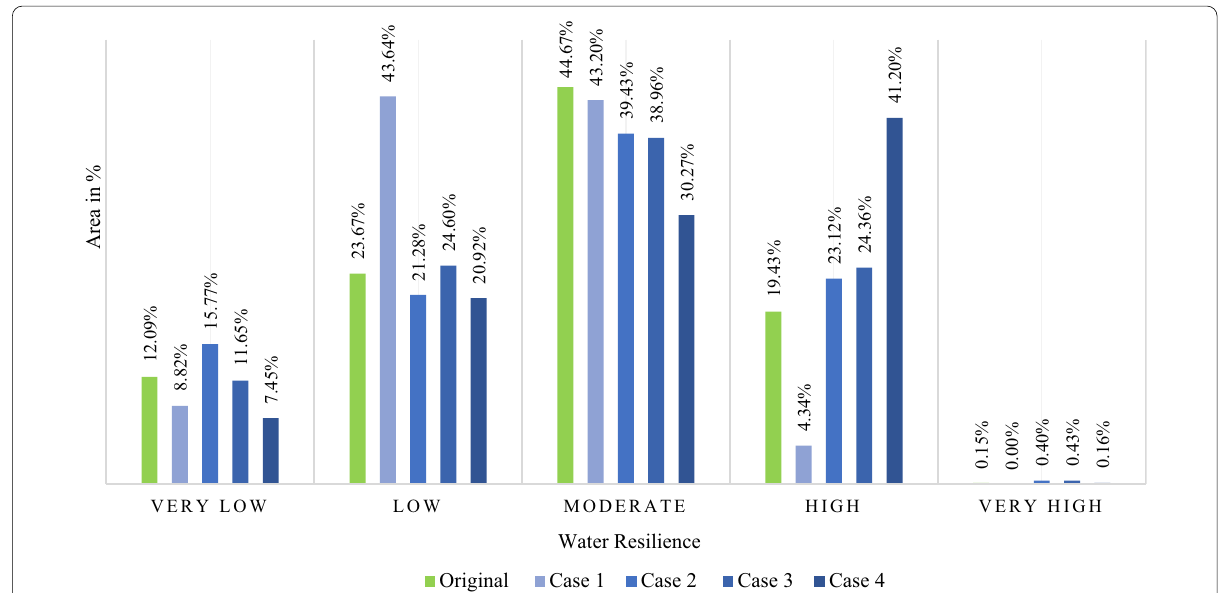
Fig. 8 Changes in the area by removing geomorphology, depth to the groundwater table, rainfall and soil depth. Case 1: Change in water resilience zone’s area by removing geomorphology parameter. Case 2: Change in water resilience zone’s area by removing depth to groundwater table parameter. Case 3: Change in water resilience zone’s area by removing rainfall parameter. Case 4: Change in water resilience zone’s area by removing soil depth